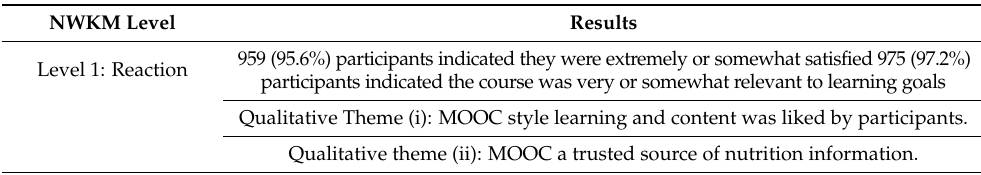
Table 4. Summary of quantitative and qualitative results mapped to NWKM. NWKM